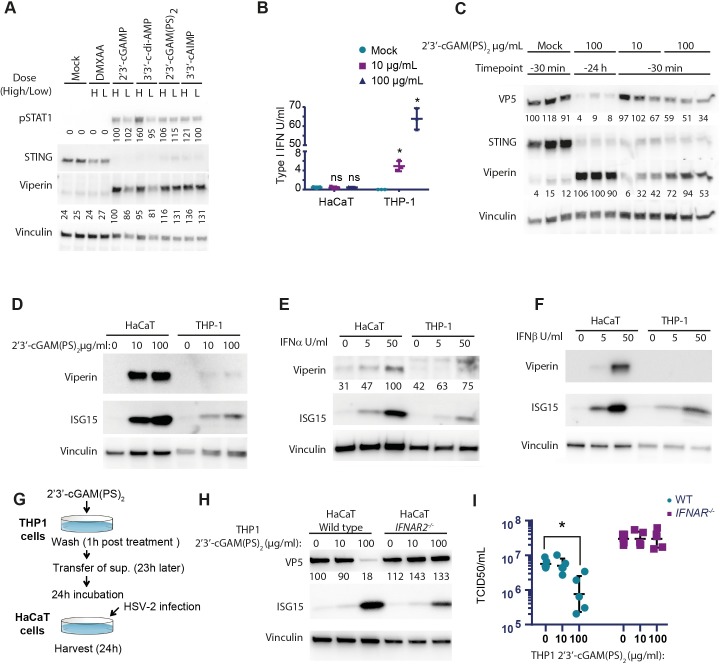
STING agonists induces type I IFN and anti-viral effect in human cells.(A) HaCaT cells were permeabilized with digitonin before stimulated with different STING agonists at a low (L: 10μg/ml) or high (H: 100μg/ml) concentration for 24 hours. Cell lysates were used for Western blotting for pSTAT1, STING and viperin. (B) HaCaT and THP-1 cells were stimulated with 2’3’-cGAM(PS)2 for 24 hours and type I IFN activity was measured in the supernatant (n = 3, * = p<0,05). (C) HaCaT cells were permeabilized with digitonin and treated with 2’3’-cGAM(PS)2 before or after infection with HSV2 (MOI 0.1) for 24 hours. Cell lysates were used for Western blotting for VP5, STING and viperin (n = 3). (D, E, F) HaCaT and THP-1 cells were stimulated with 2’3’-cGAM(PS)2, IFNα or IFNβ for 24 hours and levels of viperin and ISG15 were determined by Western blotting. (G, H, I) THP-1 cells were stimulated with 2’3’-cGAM(PS)2 for 24 hours before the media were transferred to wild type or IFNAR2-/- HaCaT cells. HaCaT cells were infected 24 hours later with HSV2 (MOI 0.1) for 24 hours. Cell lysates were used for Western blotting for VP5 and ISG15 and the media were used to determine the HSV-2 virus load. For all Western blots, Vinculin was used as loading control. n = 3, a representative sample is showed. NT, non-treated. Statistics, (B, I) Two-way ANOVA with Šidák’s multiple comparisons test; p(interaction)<0.05.